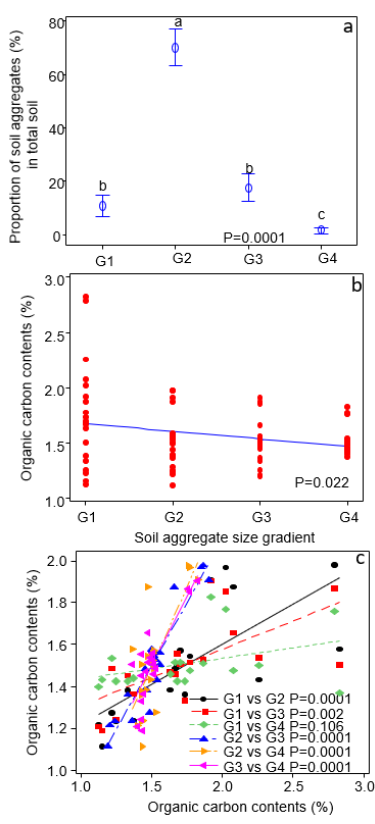
Figure 1. ( a ) The relative proportion of different soil aggregate-size classes, such as large macroaggregates (G1), small macroaggregates (G2), mesoaggregates (G3), and microaggregates (G4). Lack of letter sharing on bars represents significant statistical difference. ( b ) The soil organic carbon contents across the soil aggregate-size gradient from large macroaggregates to microaggregates as determined by the linear regression. ( c ) The correlation between organic carbon contents of various soil aggregate-size classes as determined by the linear regression.